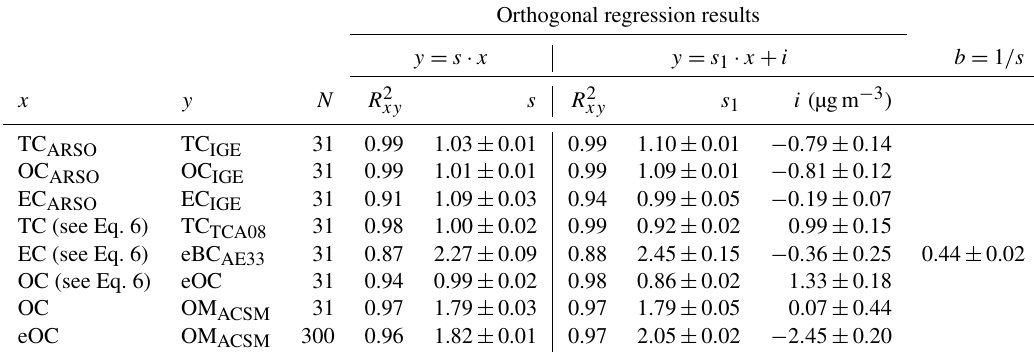
Table 2. Summarized comparison results between off-line filter measurements and 24h average values of high-time-resolution measurements of TC, BC, eOC and OM and between high-time-resolution measurements (3h) of eOC and OM ACSM measurements. Orthogonal regression